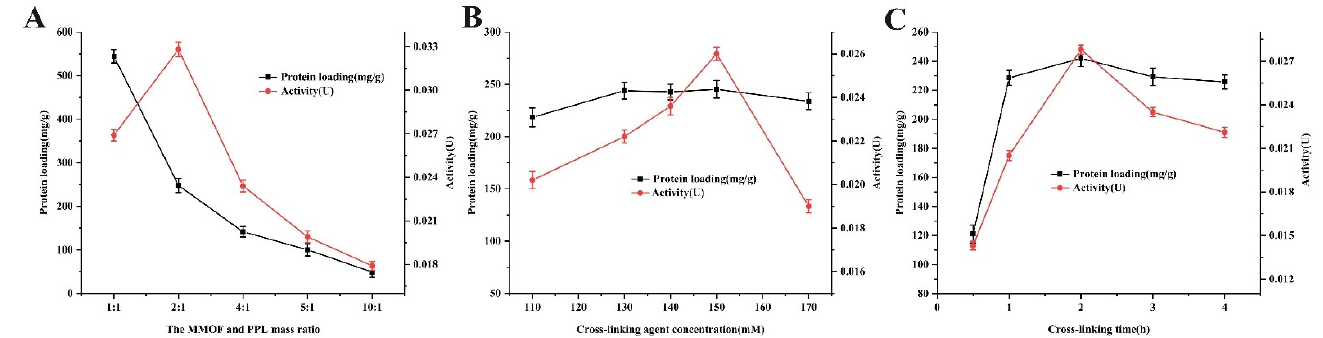
Figure 5. The effects of the MMOF and PPL mass ratio ( A ), glutaraldehyde concentration ( B ), and the cross-linking time ( C ) on protein loading and activity of immobilized PPL.